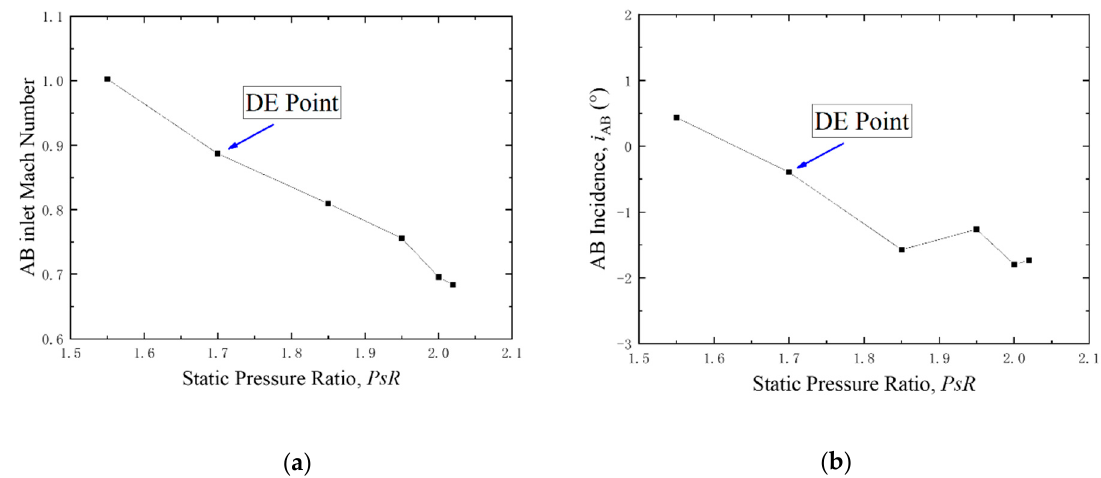
Figure 4. The inlet flow conditions of AB ( Aft Blade) . ( a ) AB inlet Mach Number, ( b ) AB incidence